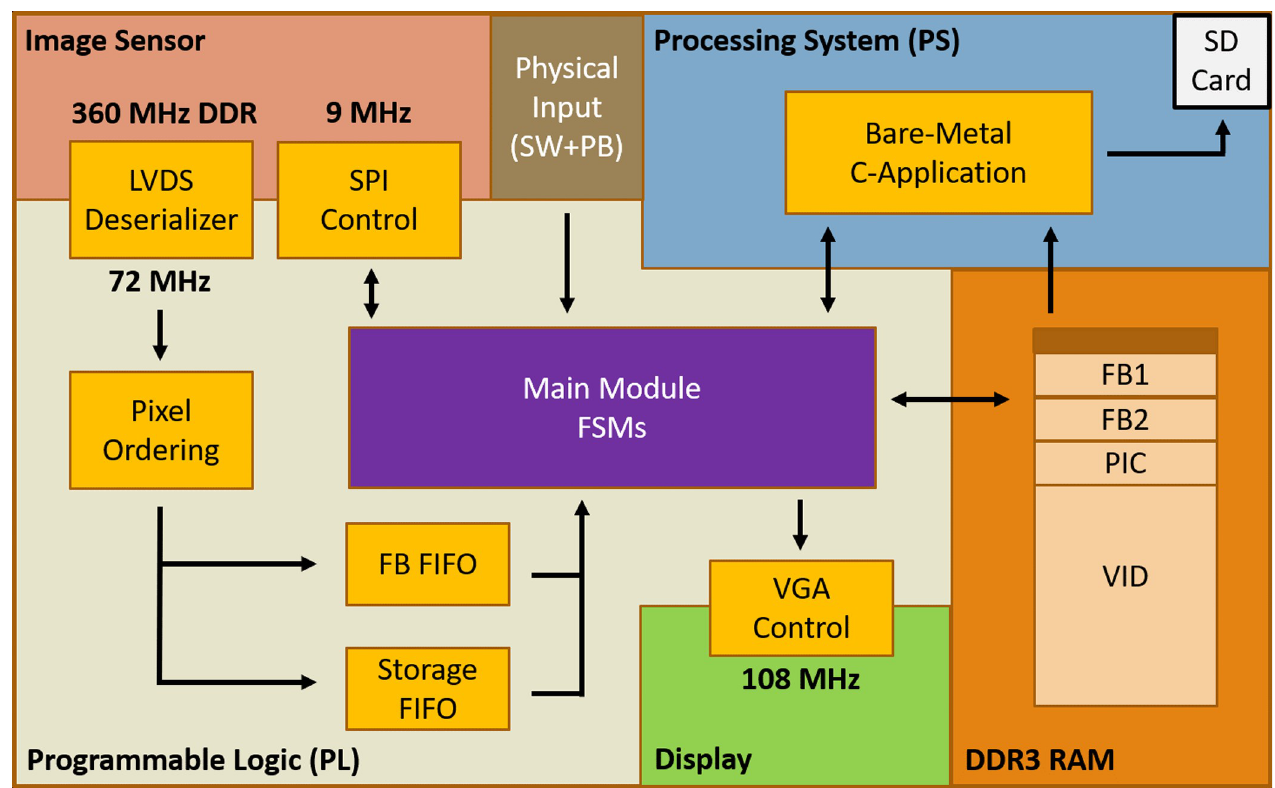
Fig 3. Design flow including camera configuration, pixel storage, and display